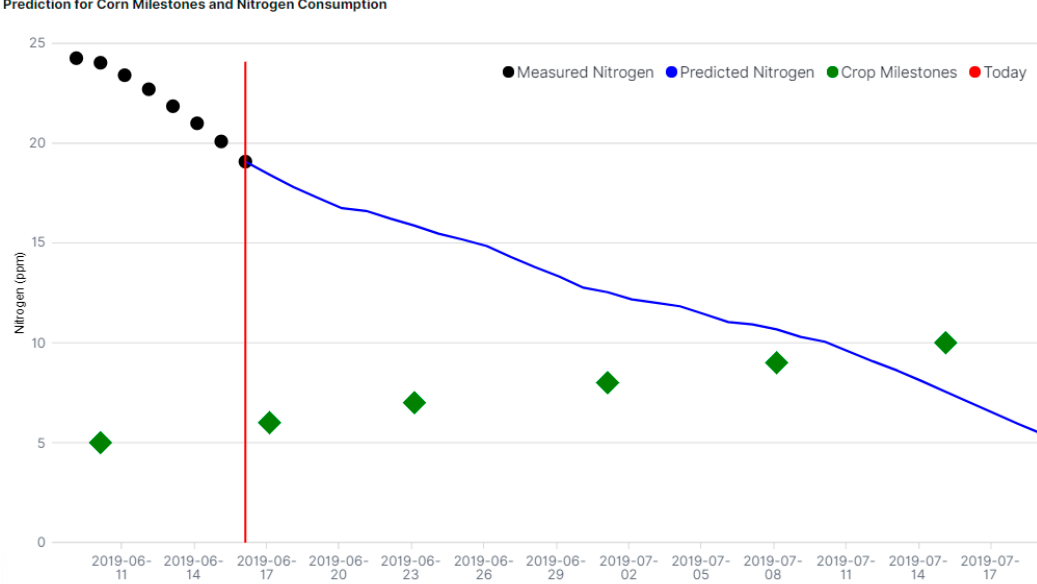
Figure 29. Simulation of prediction for corn milestones and nitrogen consumption.